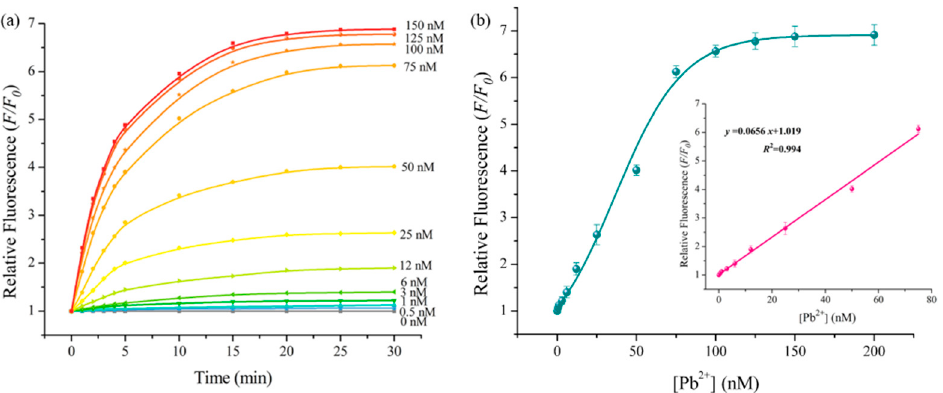
Figure 4. ( a ) Time-dependent fluorescence changes upon analyzing Pb 2+ (0~150 nM) by DNAzyme-R-PE. ( b ) The relationship between the relative intensity of DNAzyme-R-PE at 20 min and the concentrations of Pb 2+ . Inset: The linear plot of F / F 0 vs[Pb 2+ ].